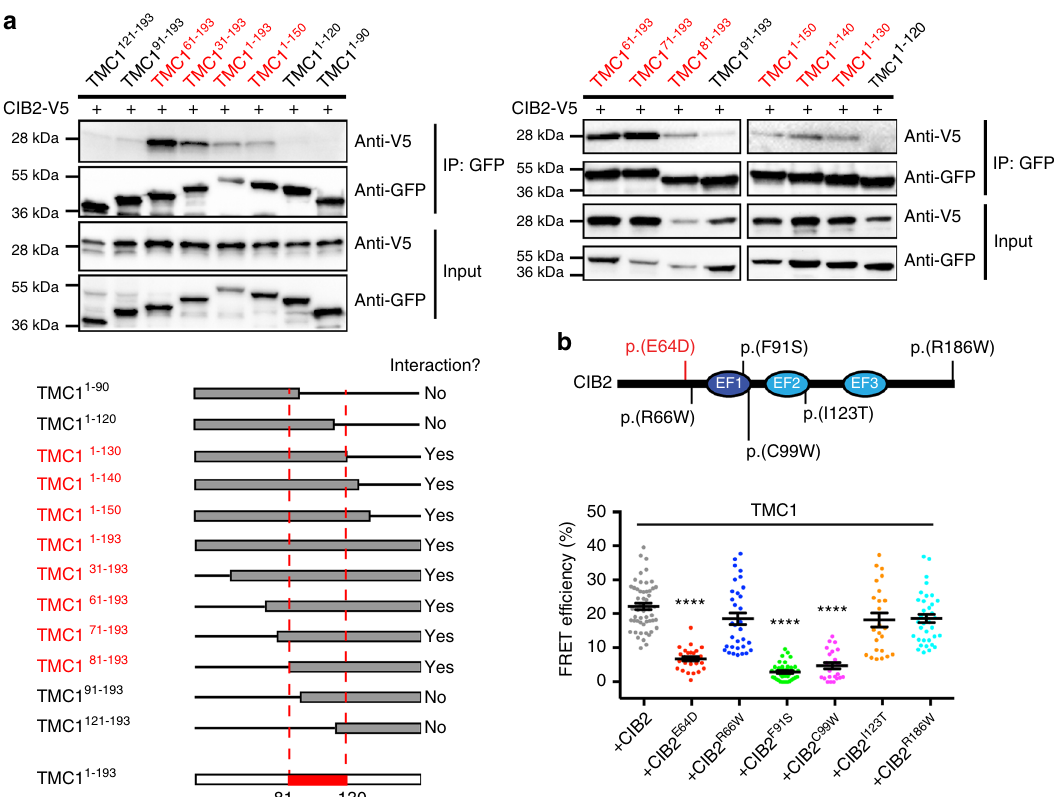
Fig. 8 Molecular mechanisms of DFNB48/USH1J deafness. a Co-immunoprecipitation assays of differentially truncated N-terminal fragments of TMC1 and full-length CIB2 ( top panels ). Schematics of truncated N-terminal fragments of TMC1 are shown on the bottom left panel . Speci fi c N-terminal domain of TMC1 (amino acids 81 – 130) is essential for binding to CIB2 (red dashed lines). b Top : The protein alteration identi fi ed in USH1J is shown in red , while the protein alterations identi fi ed in DFNB48 are shown in black . Bottom : Quantitative analysis of FRET ef fi ciency in cells co-expressing EGFP tagged human TMC1 (donor) and V5 tagged human CIB2 with deafness causing mutations. Error bars represent SEM. Asterisks indicate statistical signi fi cance of FRET ef fi ciency changes relative to the control interaction of TMC1 with wild-type CIB2 (ANOVA with Dunnett ’ s Cib2 F91S/F91S mice: To generate Cib2 F91S/F91S knock-in mice ( Cib2 F91S/F91S ), a 6.65-kb region, including Cib2 exon 4 was ampli fi ed from the genomic DNA of